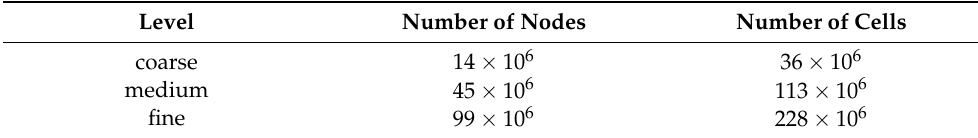
Figure 4. Cross-sectional view of mesh topology. Table 4. Mesh